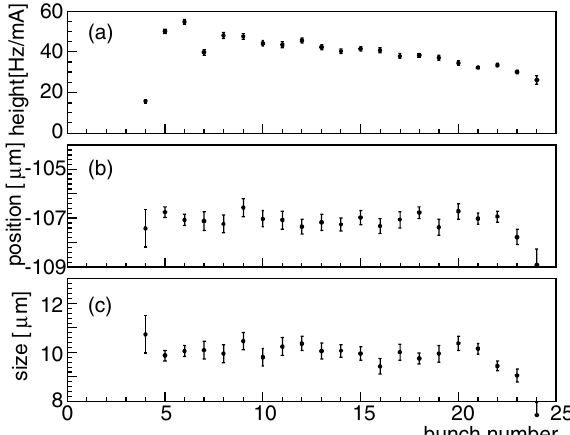
FIG. 6. Bunch dependence of the 20-bunch beam (vertical measurement). (a) The peak height; (b) the vertical peak ; (c) the peak width (cid:11) (cid:5) y (cid:6) meas . position y p the average of (cid:11) weighted by its error, and the error of meas the average itself. The results are listed in the 4th and 5th columns of Table II. The 6th and 7th columns are the chi square per degree of freedom ( (cid:15) 2 =(cid:16) ) and the rescaled (cid:1)(cid:1)(cid:1)(cid:1)(cid:1)(cid:1)(cid:1)(cid:1)(cid:1)(cid:1)(cid:1) p (cid:3) h (cid:17)(cid:11) i (cid:15) 2 =(cid:16) error, i.e., (cid:28) (cid:11) bunch meas